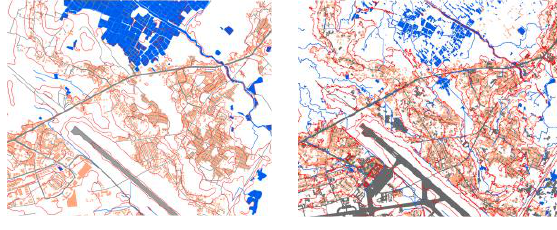
Figure 5. Comparison the reference data (left) and the resulted data